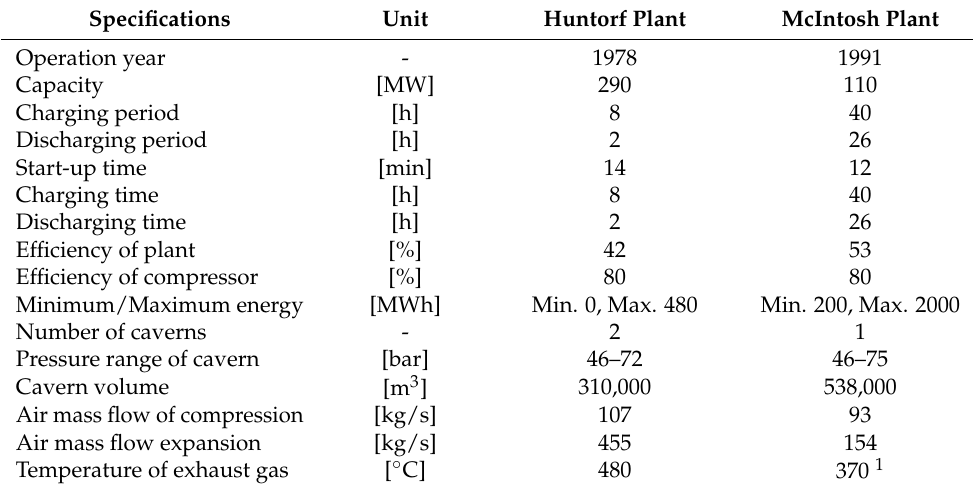
Table 1. Technical specifications for the Huntorf and McIntosh D-CAES plants [28,30,34,36].